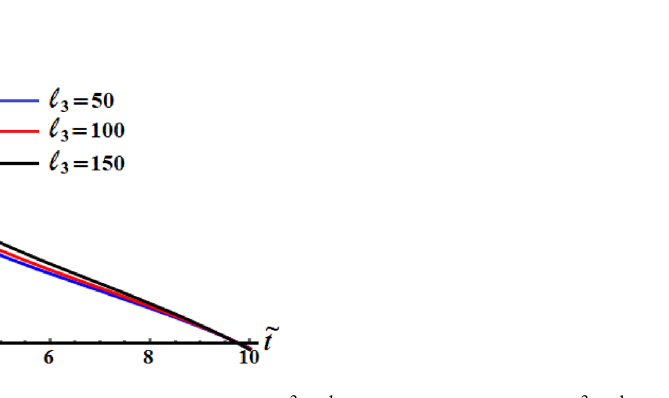
Figure 12. Demonstrates ˜ M ( ˜ t ) when (ℓ 1 , ℓ 2 ) = ( 200, 150 ) kg m 2 s − 1 at ℓ 3 ( = 50, 100, 150 ) kg m 2 s − 1 .